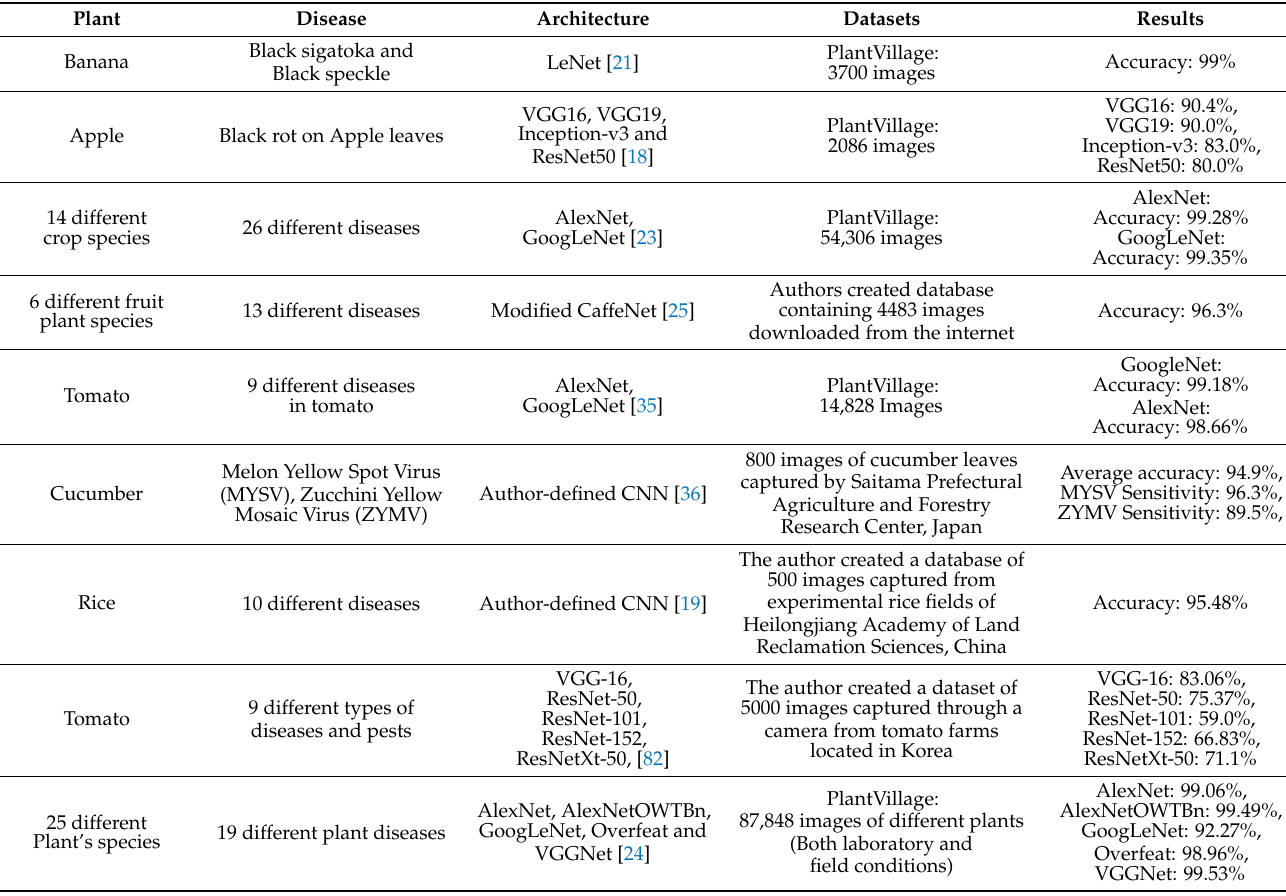
Table 6. Comparative analysis of DCNN in identification of plant leaf